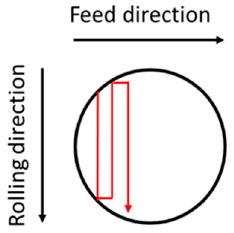
Figure 1. Scheme of the meandering pattern used for deep rolling and microblasting with indication of